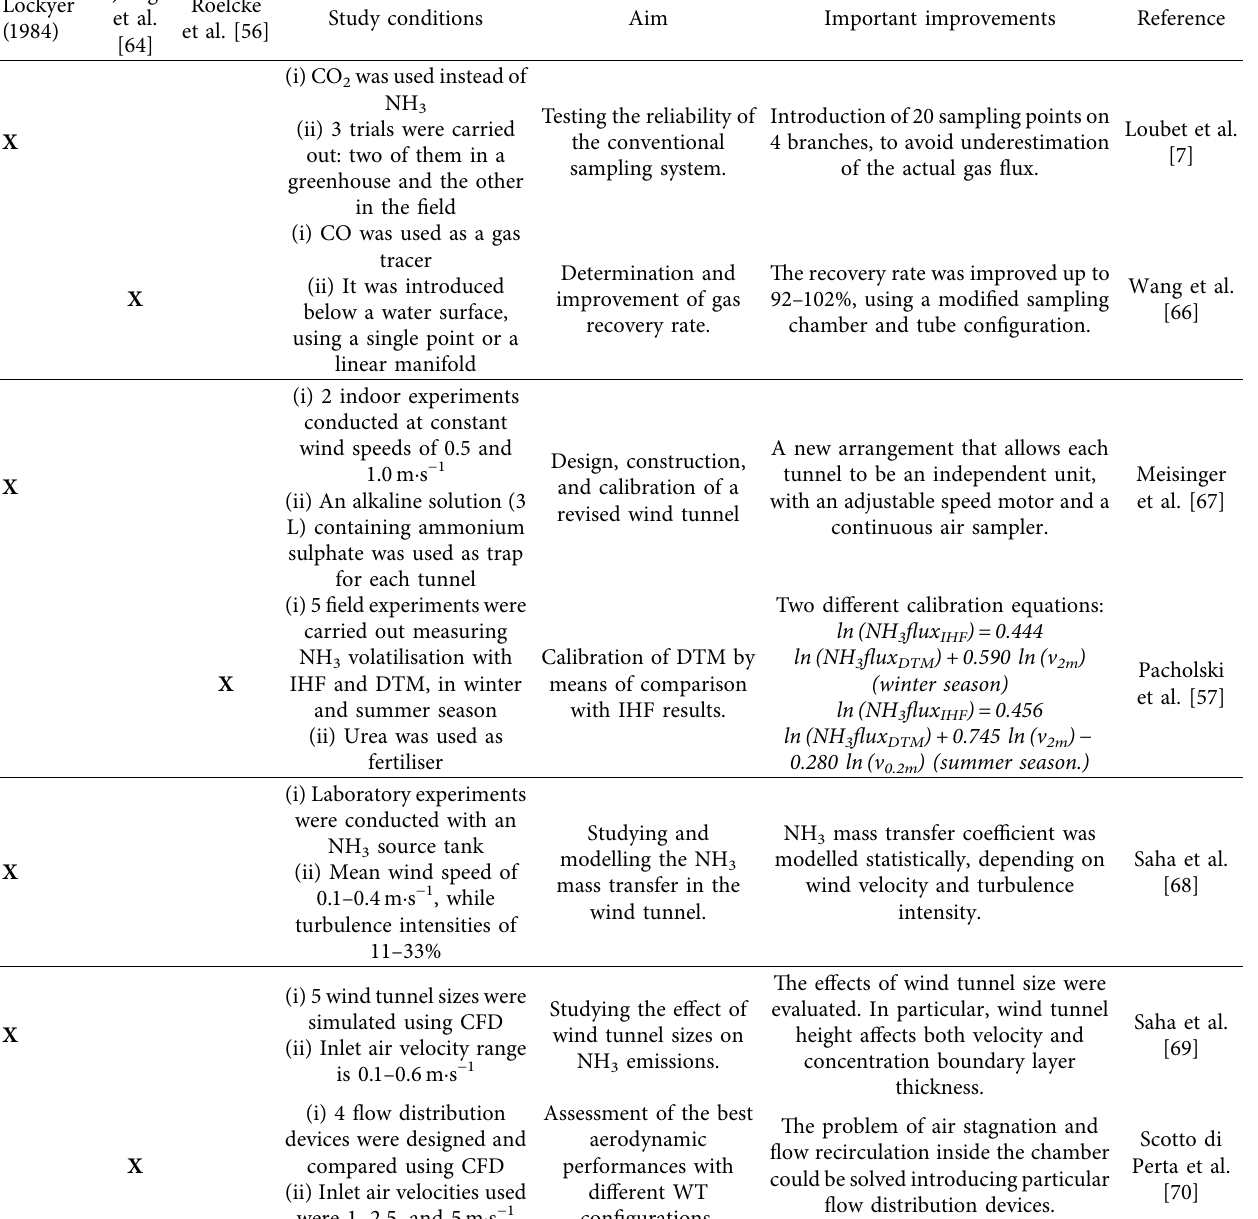
Table 3: Summary of main studies focused on dynamic chamber method